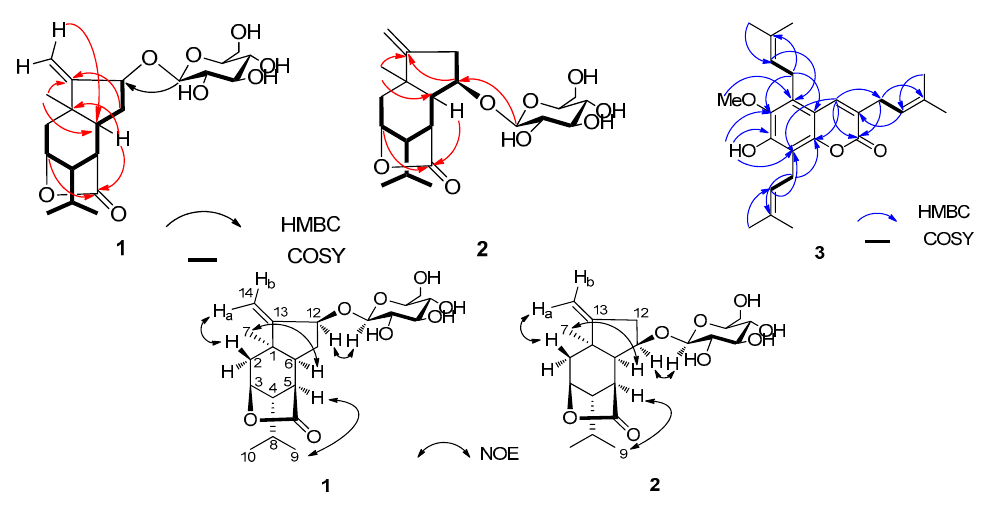
Figure 2. Selected 2D NMR correlations for compounds 1 – 3 .